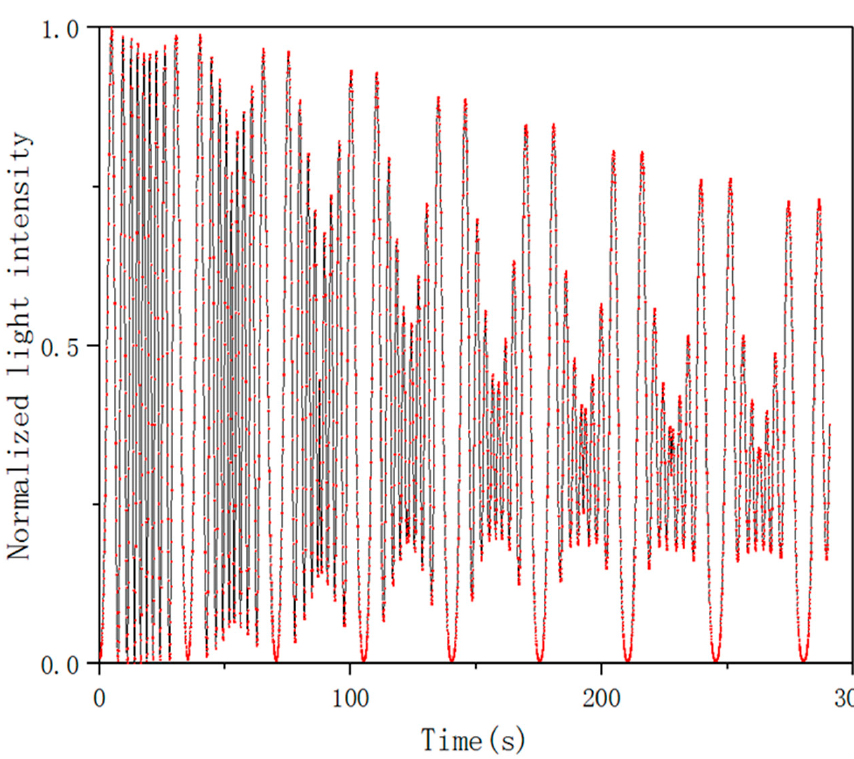
Figure 7. Changes in the modulation curve after multiple voltage cycles.